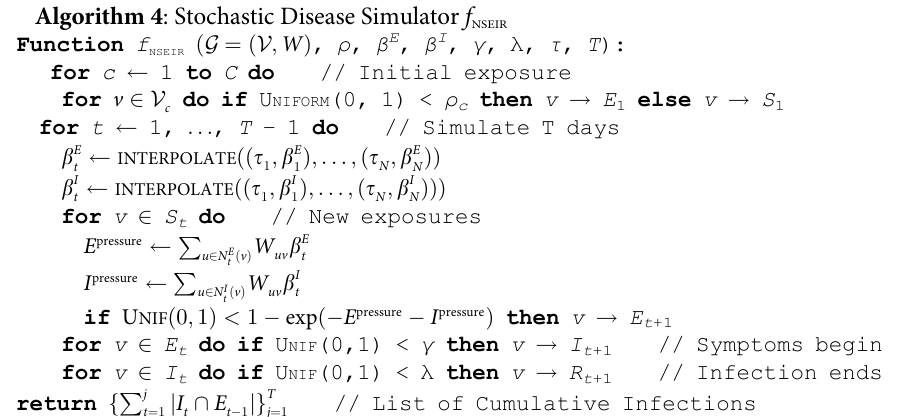
Algorithm 4 : Stochastic Disease Simulator f